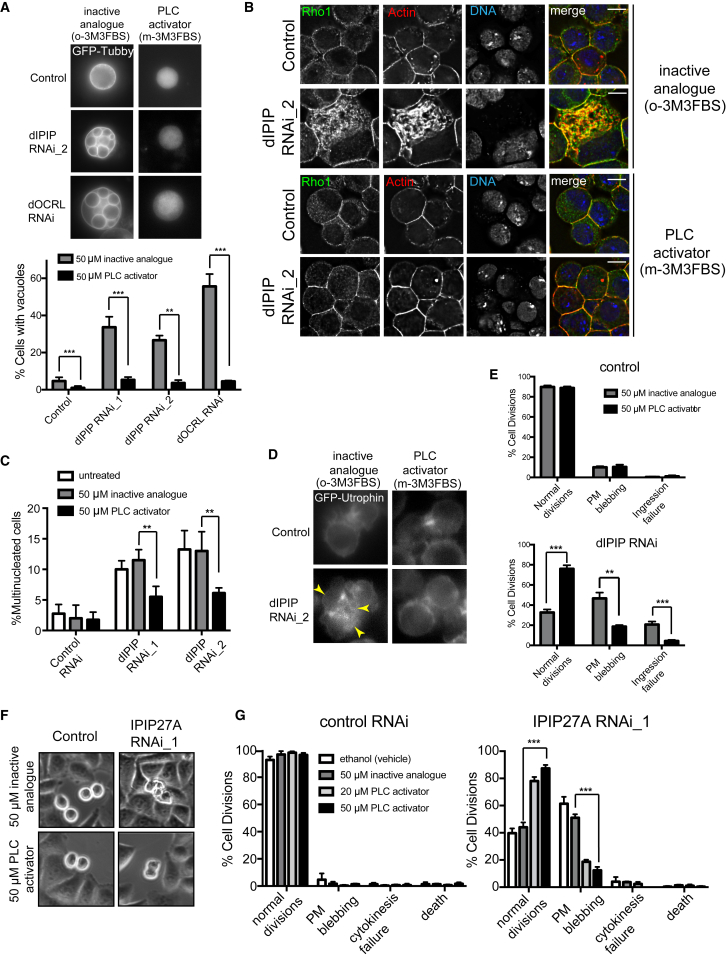
Cortical Instability and Cytokinesis Failure upon dIPIP or IPIP27A Depletion Is Due to Dysregulated PtdIns(4,5)P2 Homeostasis(A) Top: live stills of S2 cells stably expressing GFP-Tubby depleted of dIPIP or dOCRL and treated with 50 μM inactive analog (o-3M3FBS) or PLC activator (m-3M3FBS). Bottom: quantification of PtdIns(4,5)P2-rich vacuoles. Bars represent the mean of 3 experiments with 250–400 cells analyzed per condition per experiment. ∗∗p < 0.001, ∗∗∗p < 0.0001, Student’s t test.(B) S2 cells depleted of dIPIP or dOCRL and treated with 50 μM of inactive analog or PLC activator, followed by staining with anti-Rho1 (green), phalloidin-TRITC (red), and Hoechst 33342 (blue). Scale bar, 5 μm.(C) Quantitation of multinucleation in S2 cells depleted of dIPIP and treated with 50 μM inactive analog or PLC activator. Bars represent the mean of 3 experiments with 350–500 cells analyzed per condition per experiment. ∗∗∗p < 0.0001, ∗∗p < 0.001, ∗p < 0.05, Student’s t test.(D) Live time-lapse stills of control or dIPIP-depleted S2 cells stably expressing GFP-Utrophin treated with inactive analog or PLC activator. Arrowheads indicate plasma membrane blebs during cytokinesis.(E) Quantification of cell division phenotypes, showing the mean of 3 experiments with 50 cells analyzed per condition per experiment. Error bars indicate SEM. ∗∗∗p < 0.0001, ∗∗p < 0.001, chi-square analysis.(F) Live time-lapse stills of control or IPIP27A-depleted HeLa cells following treatment with 50 μM inactive analog or PLC activator.(G) Quantification of phenotypes, showing the mean of 3 experiments with 150–200 cells analyzed per condition per experiment. Error bars indicate SEM. ∗∗∗p < 0.0001, chi-square analysis.See also Figure S3.